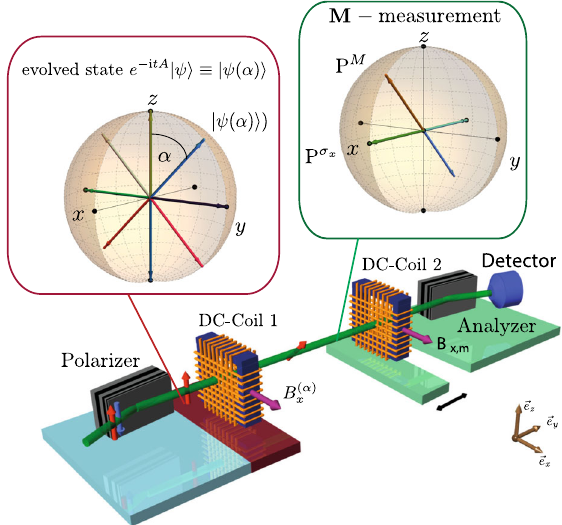
Fig. 2 Experimental setup for measurement of the q-rms error pro fi le ε α of measuring process M . The setup consists of three regions: Blue: preparation of the initial state ψ j i ¼ ð 1 ; 0 Þ T (cid:3) þ z j i .